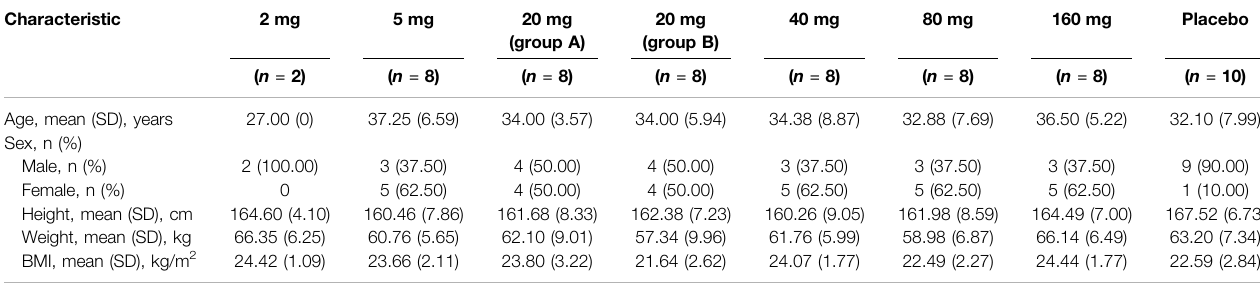
TABLE 1 | Summary of study participants ’ demographic and basic clinical characteristic.